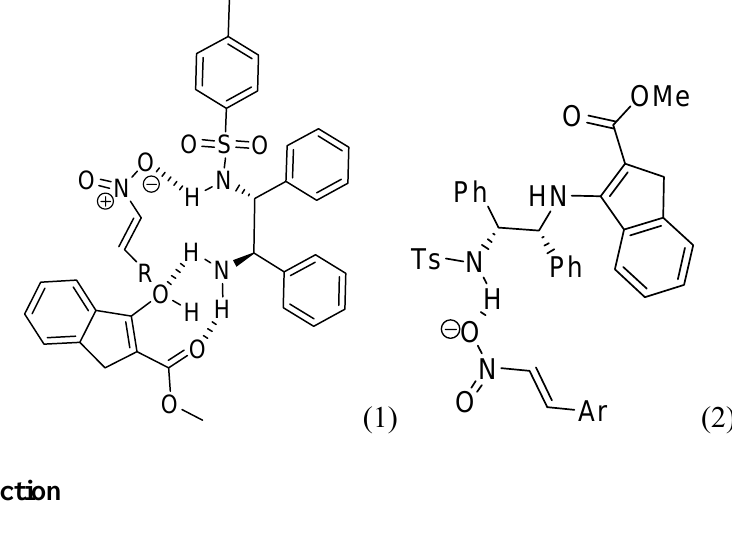
Figure 2. Proposed catalytic reaction mode via dual activation